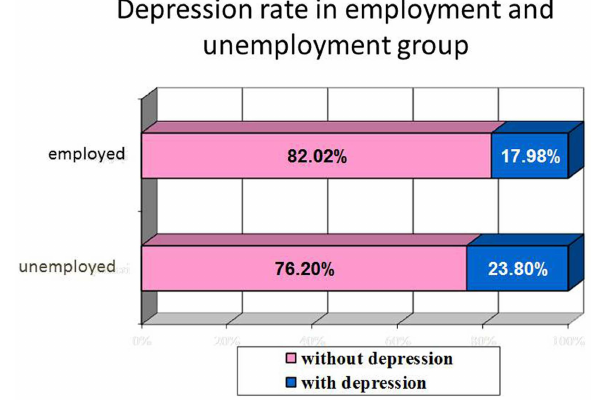
FIGURE 3 | Correlation between employment status and depression rate .